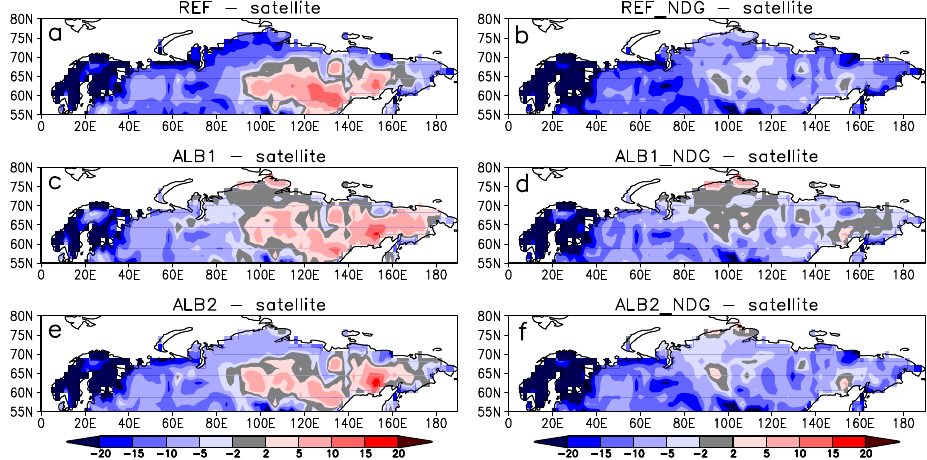
Figure 10. Differences in average snow-off date between the six ECHAM5 experiments and the satellite retrievals.